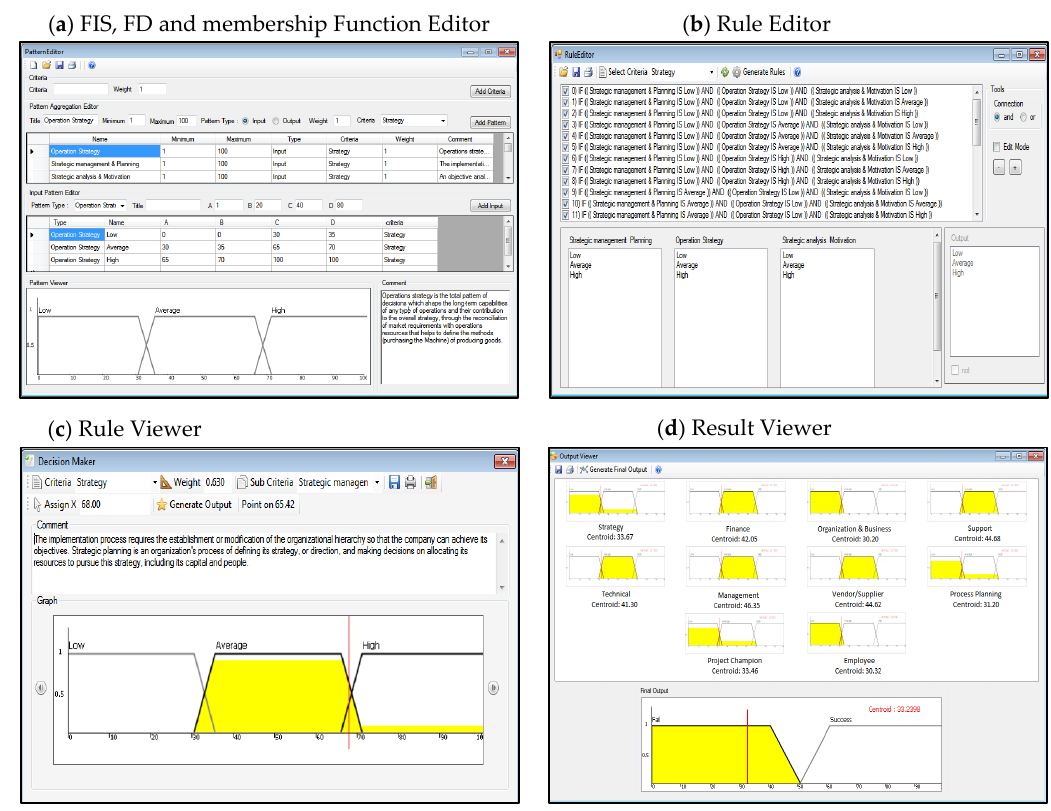
Figure 9. Screenshots of graphical user interfaces available in the AMT prediction tool.